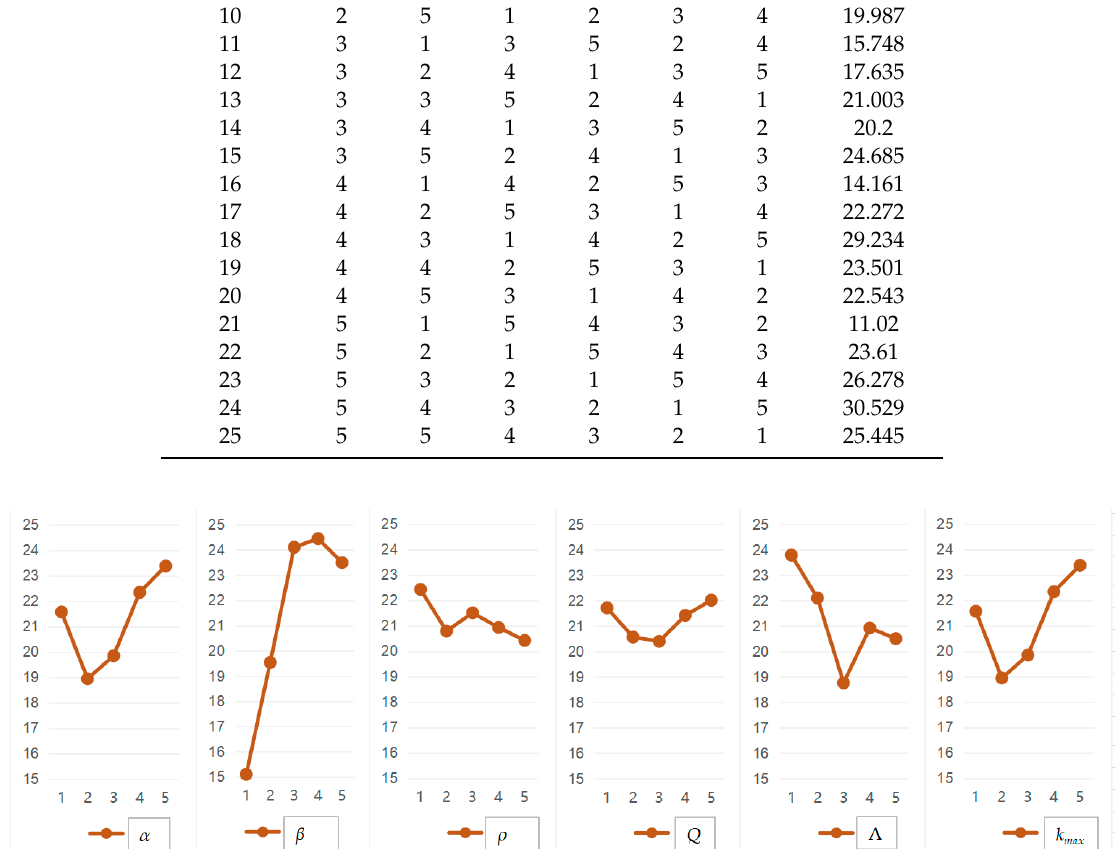
ff ect graph of ACO.